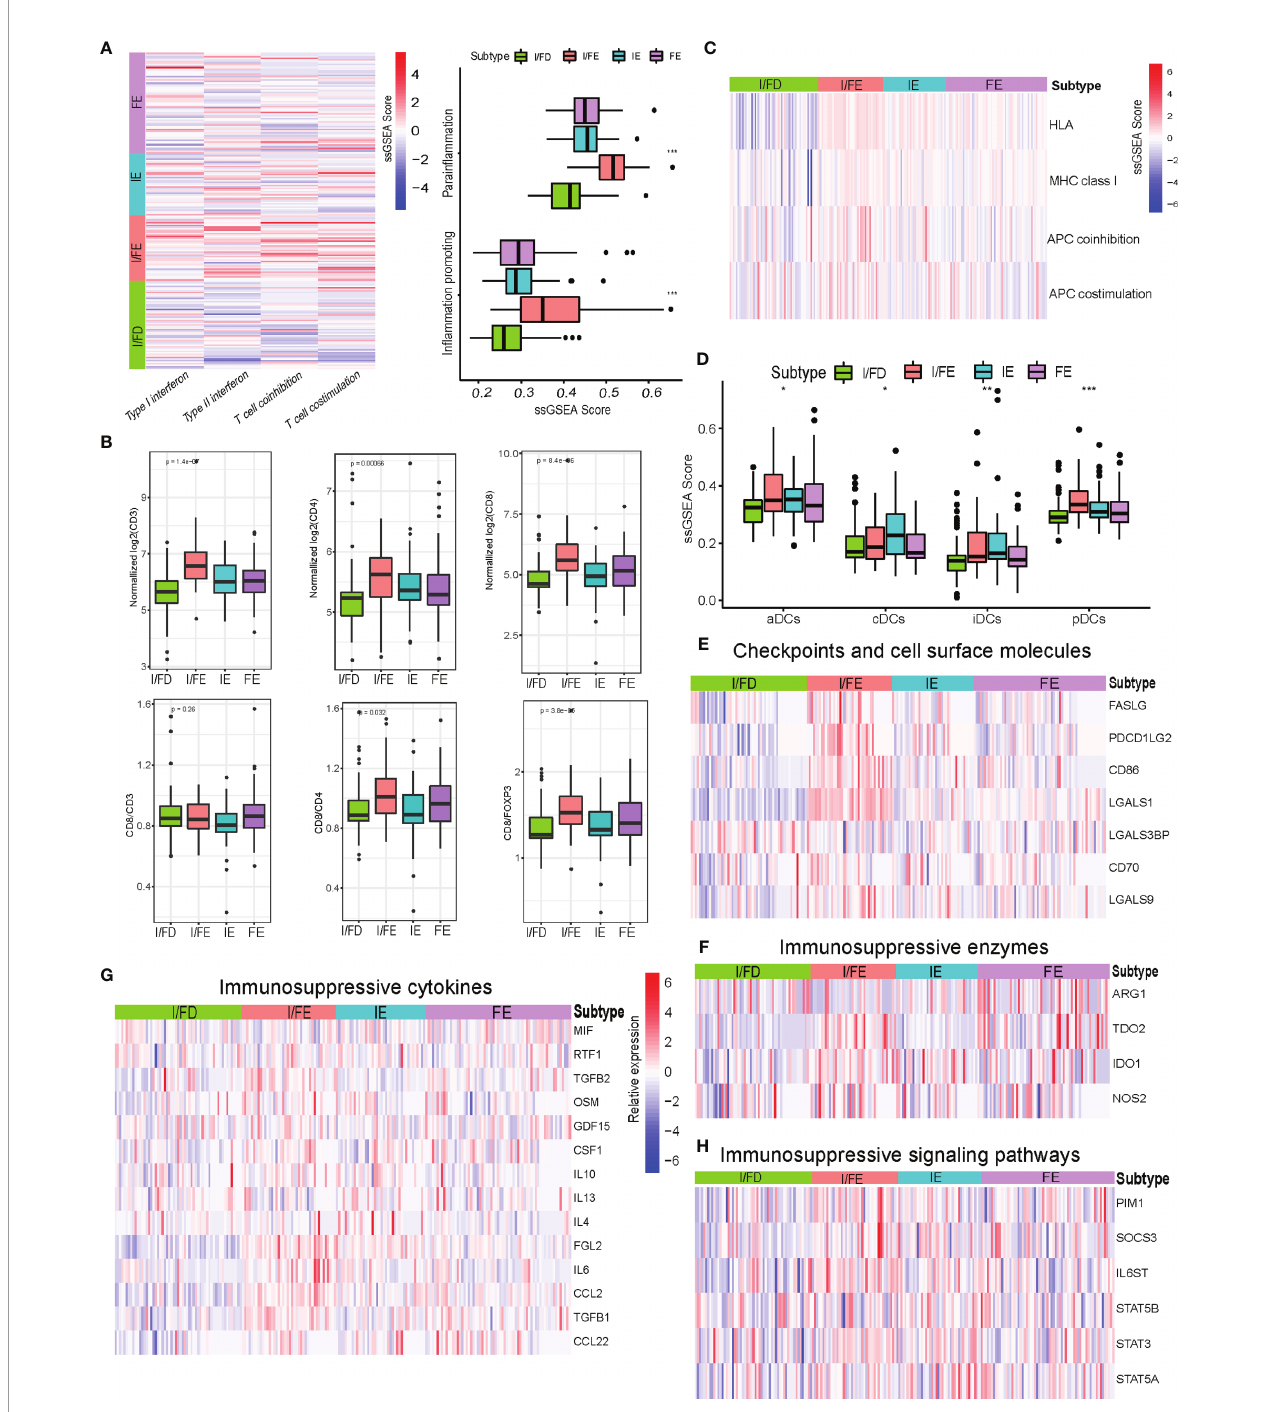
FIGURE 5 | (A) Heatmap of median ssGSEA scores of speci fi c antitumor immune responses associated with T-cell activation among the four subtypes. ssGSEA scores of two in fl ammation signatures (parain fl ammation and in fl ammation promoting). (B) Total CD3, CD4, and CD8, and the ratios of CD8/CD3, CD8/CD4, and CD8/FOXP3 to each for available matched samples respectivelyamongthe four subtypes. (C) Heat map of median ssGSEA scores ofgene signatures upregulated in speci fi c antitumor immune responses relatedto APC activation amongthe four subgroups. (D) Box of median ssGSEA scores of DCincludingcDCs, iDCs, pDCs, and aDCs among the four subtypes. (E) The comparison of immunosuppressive checkpoints and cell surface molecules among the four subtypes. (F) The comparison of immunosuppressive enzymes amongthe four subtypes. (G) The comparisonof immunosuppressive cytokines amongthe four subtypes. (H) The comparison of immunosuppressive signalingpathwaysamong the foursubtypes. P values <0.05 were considered signi fi cant (ns, P > 0.05; *,P < 0.05; **, P < 0.005; ***, P <